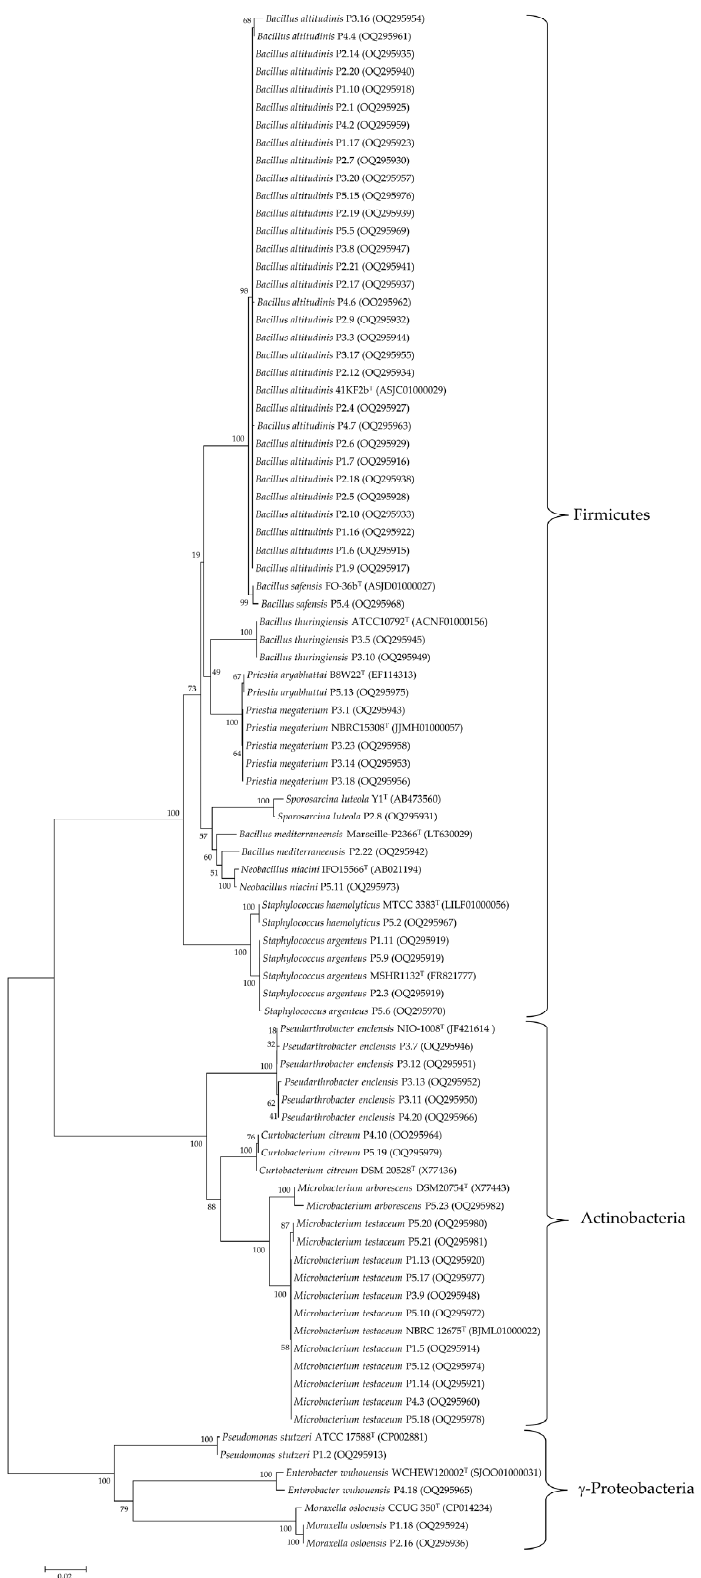
Figure 1. Phylogenetic tree based on 16S rDNA sequences of bacterial isolates isolated from tea leaves along with the sequences from reference strains using the neighbor-joining method. The number in each branch shows the bootstrap percentage. Bars represent 0.02 substitutions per nucleotide position. The superscript letter “T” indicates the type